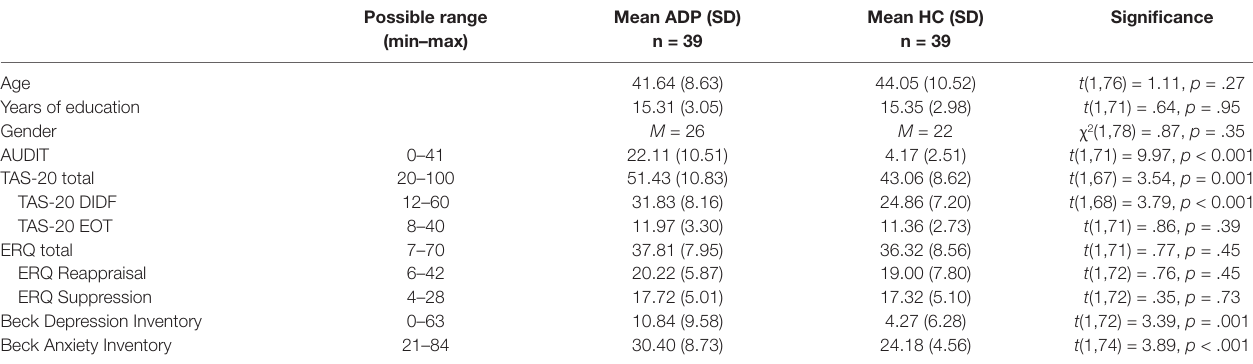
TABLE 1 | Sample characteristics. This table shows the results for the analyses of the sample characteristics. Values are denoted as mean (standard deviation). Total number of participants per comparison may vary due to a small number of missing values. SD, standard deviation; AUDIT, Alcohol Use Disorders Identification Test; TAS, Toronto Alexithymia Scale; DIDF, difficulties identifying and describing feelings; EOT, externally oriented thinking; ERQ, emotion regulation questionnaire. ERQ Reappraisal and Suppression are subscales of the ERQ. Possible range (min–max)